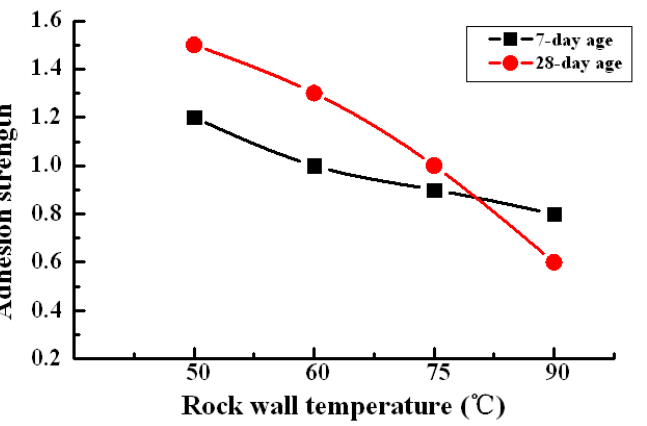
Figure 9. Data of bond strength between surrounding rock and shotcrete under different working conditions [75].